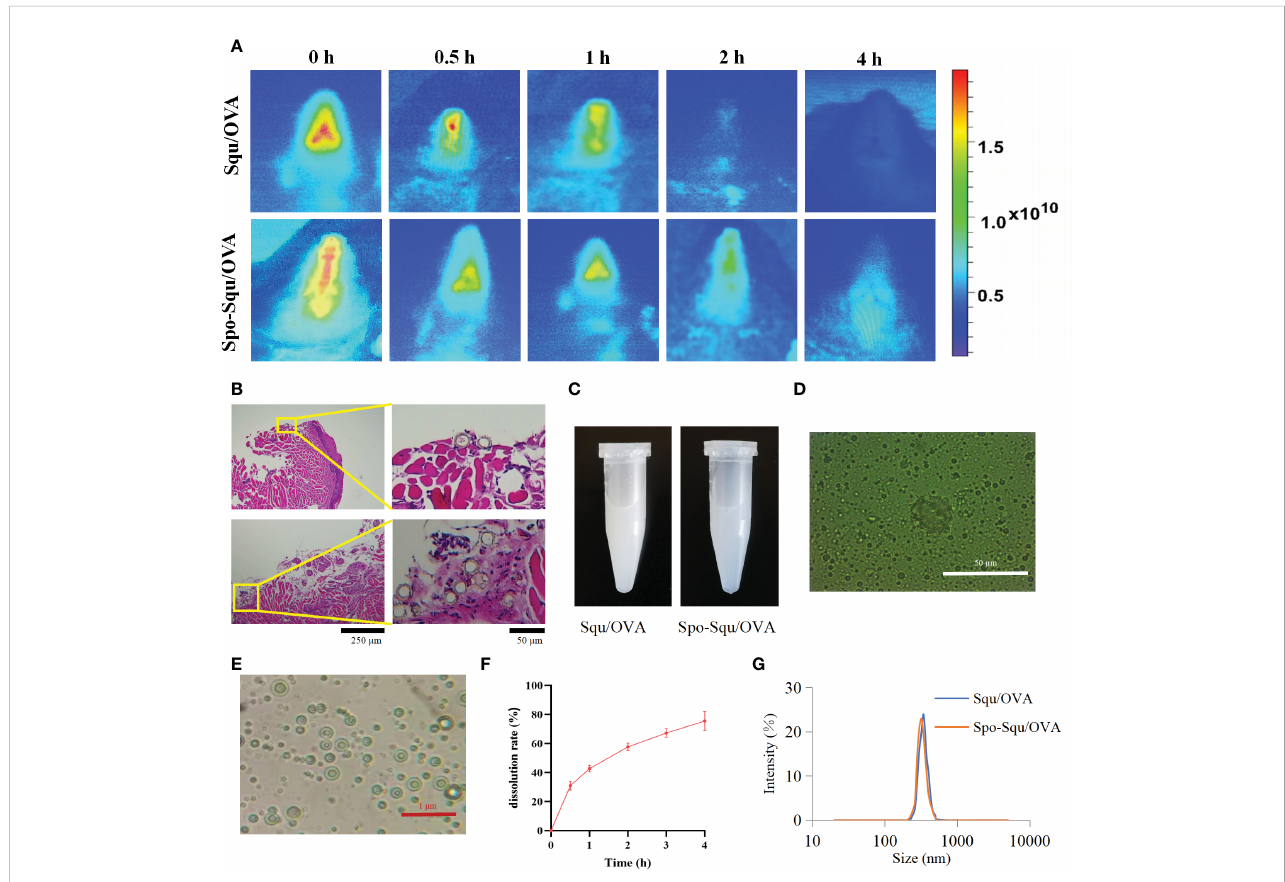
FIGURE 4 Sporopollenin increase the retention and release of antigen. (A) Retention of Squ/OVA and Spo-Squ/OVA in nasal mucosa. (B) Spo-Squ /OVA enters the nasal mucosa 4 hours after administration. (C) The appearance of the Squ /OVA and Spo-Squ/OVA w/o/w emulsion. (D) The fl uorescence microscopy images of Spo-Squ/OVA. Scale bar: 50 µm. (E) The microscopy images of Spo-Squ /OVA. Scale bar: 1 µm. (F) In vitro release curve of OVA from Spo- Squ/OVA in phosphate buffered saline. (G) The particle size of Squ/OVA and